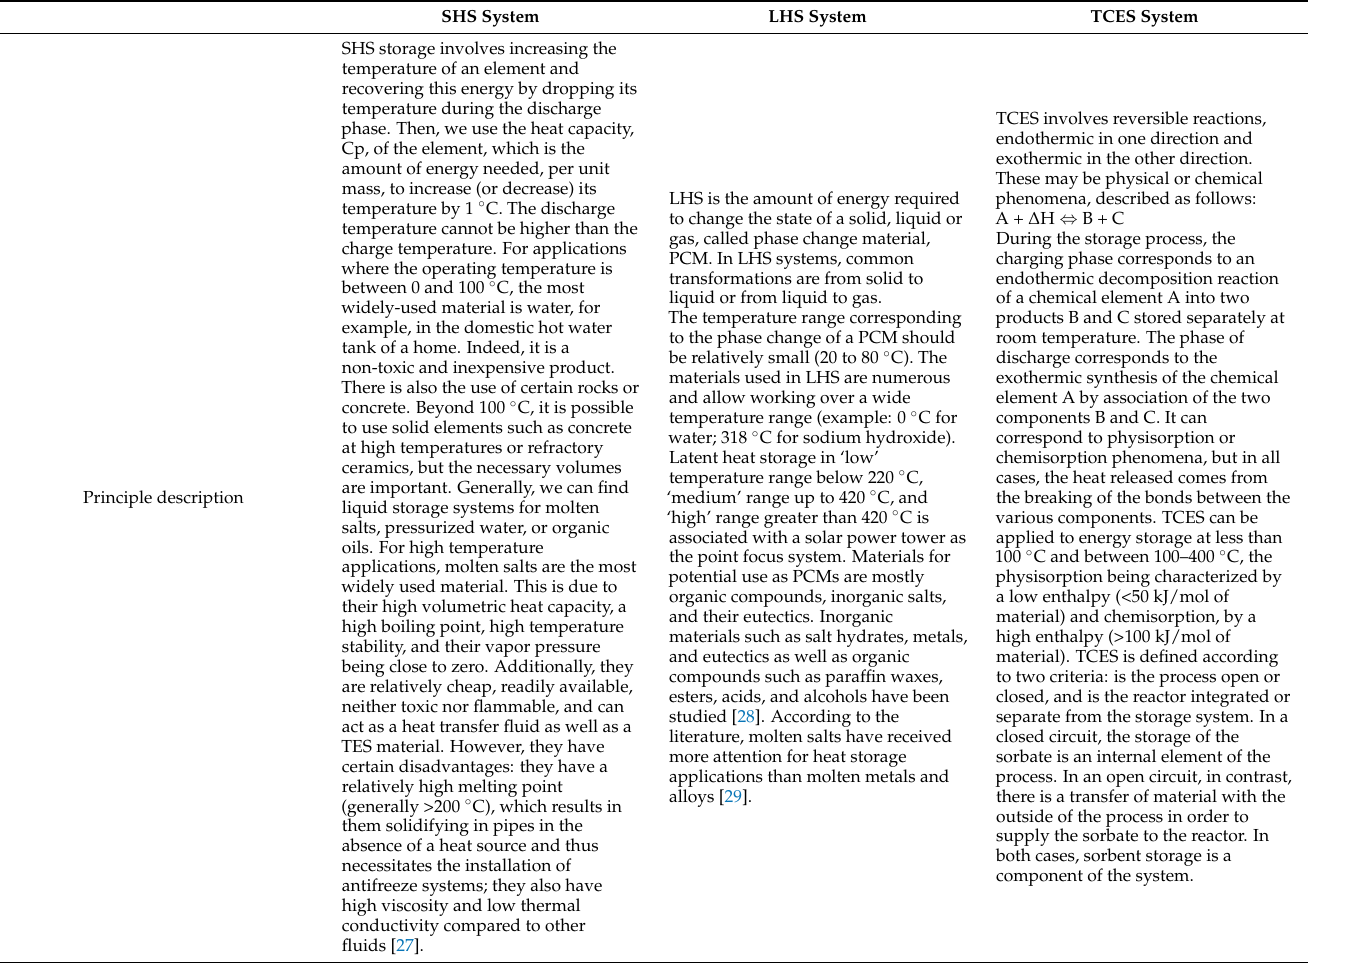
Table 1. List of thermal energy storage systems and their